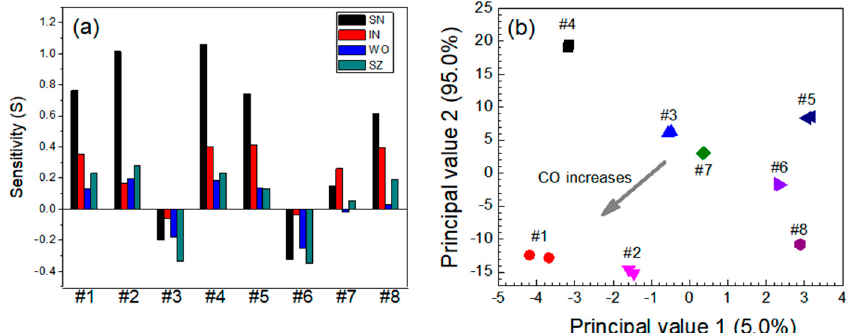
Figure 6. ( a ) Responses of the sensors and ( b ) principal component analysis (PCA)-based dual-gas sensor monitoring for the CO-NO 2 system. Note that #1–#8 represent 30 ppm CO + 0 ppm NO 2 , 60 ppm CO + 0 ppm NO 2 , 0 ppm CO + 0.3 ppm NO 2 , 30 ppm CO + 0.3 ppm NO 2 , 60 ppm CO + 0.3 ppm NO 2 , 0 ppm CO + 0.6 ppm NO 2 , 30 ppm CO + 0.6 ppm NO 2 , and 60 ppm CO + 0.6 ppm NO 2 , respectively.